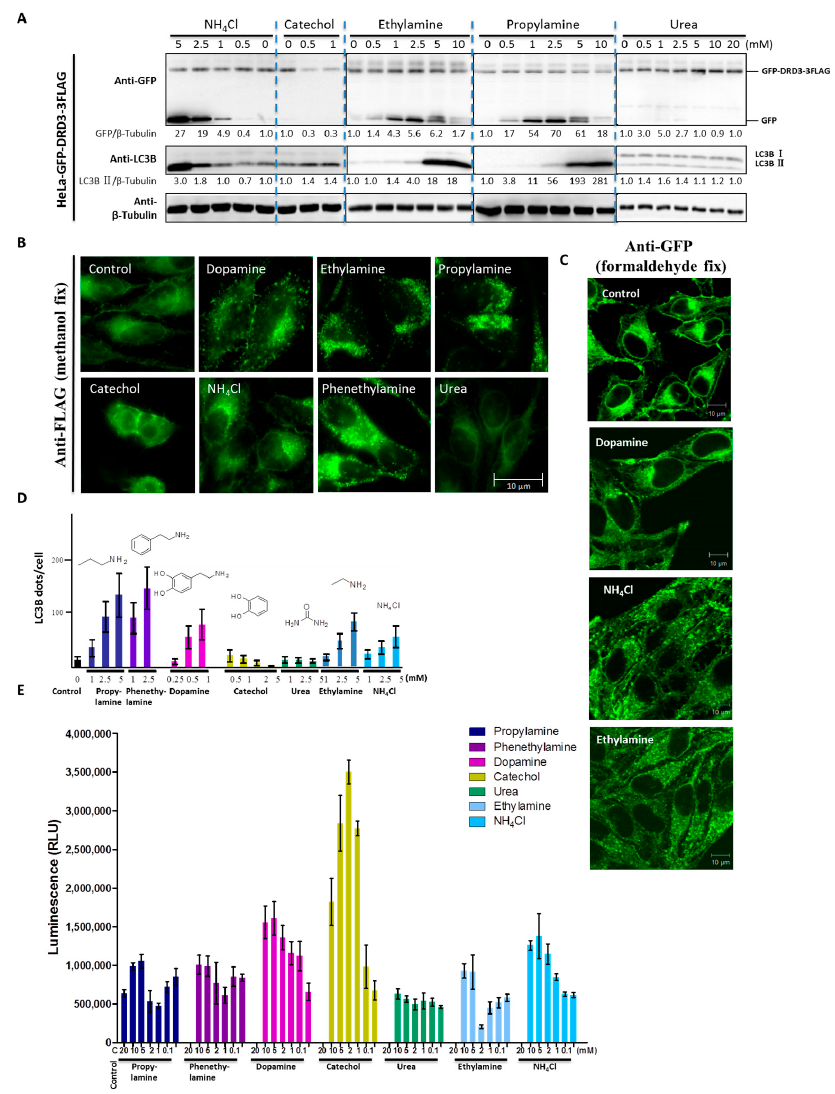
Figure 4. The free amino group is responsible for dopamine and monoamine-induced autophagy and DRD3 internalization. ( A ) Representative Western blots show GFP fragment and autophagy